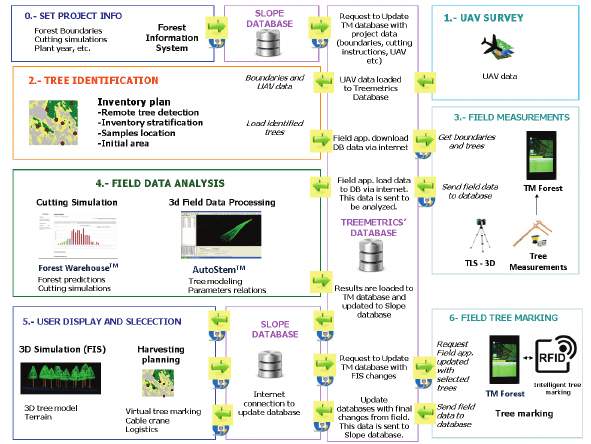
Figure 1. Data workflow defined to support forest